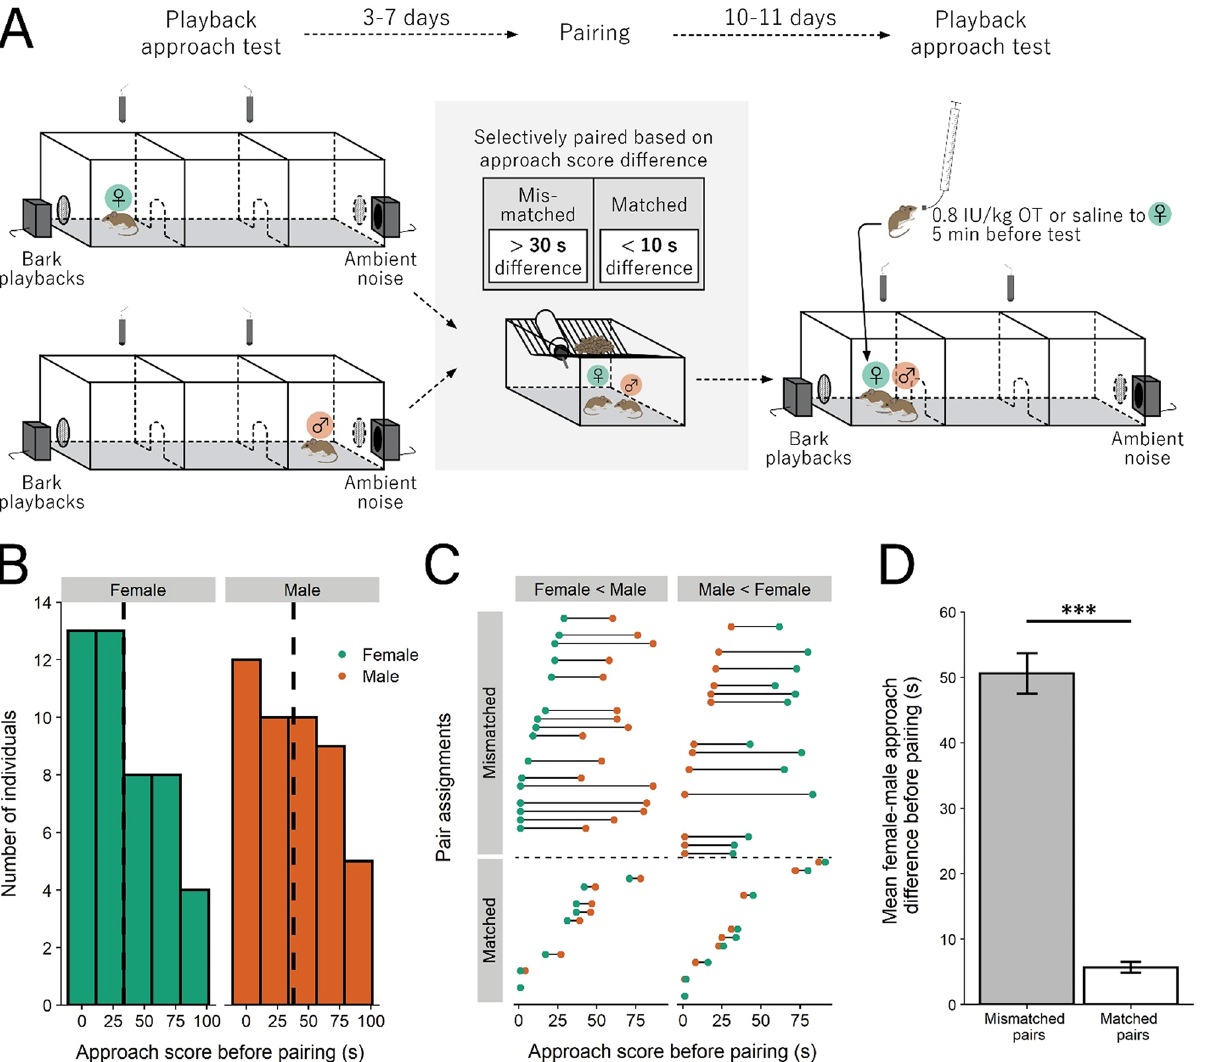
Figure 2. Selective pairing to form mismatched and matched pairs based on initial social approach score. ( A ) Experimental design, adapted from 38 . Approach is the amount of time spent in the chamber closet to the bark playback speaker. ( B ) Distribution of approach scores for females and males before pairing; dotted line is mean approach. ( C ) Stratified randomized pair assignments; mismatched pairs had ≥ 30 s difference in approach score between mates while matched pairs had ≤ 10 s difference. ( D ) The female-male approach difference for mismatched pairs was significantly greater than that for matched pairs (*** = p < 0.001). Error bars are ±